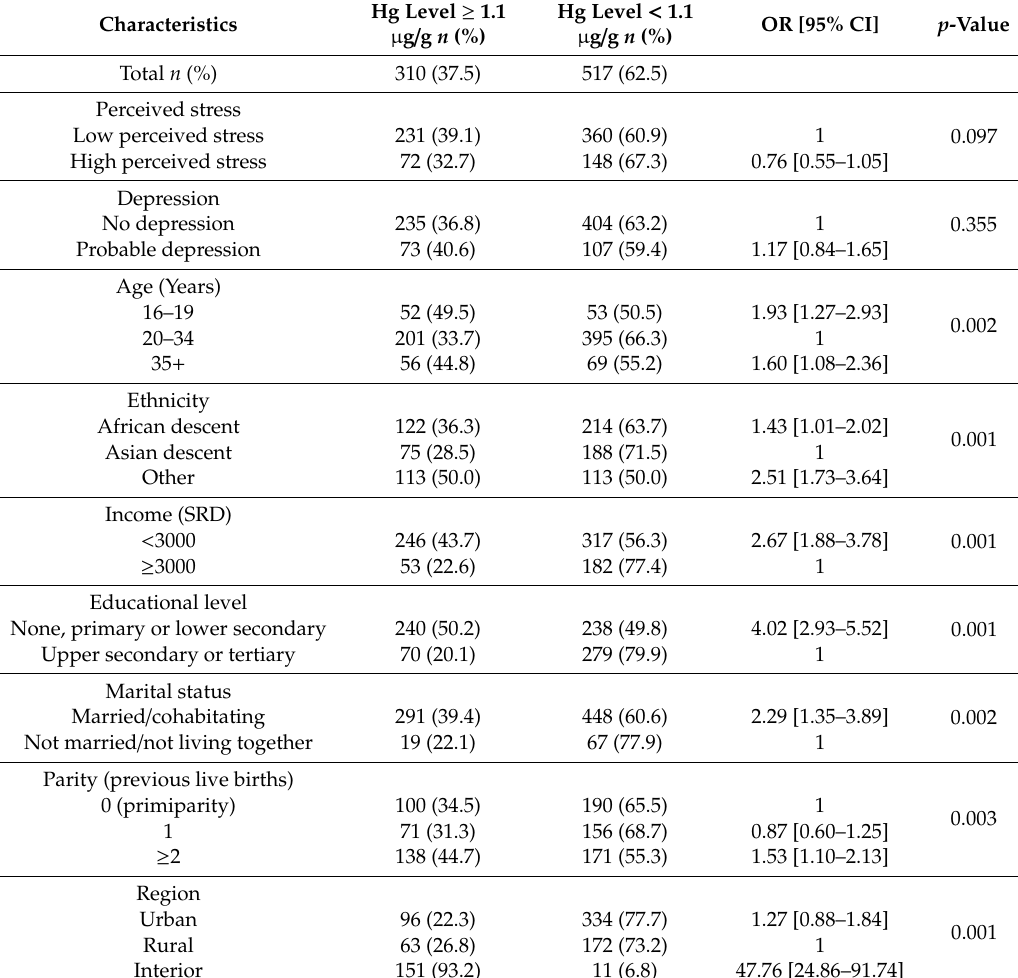
Table 2. Perceived stress, depression, and demographic characteristics by chemical stressor (mercury) ( n =